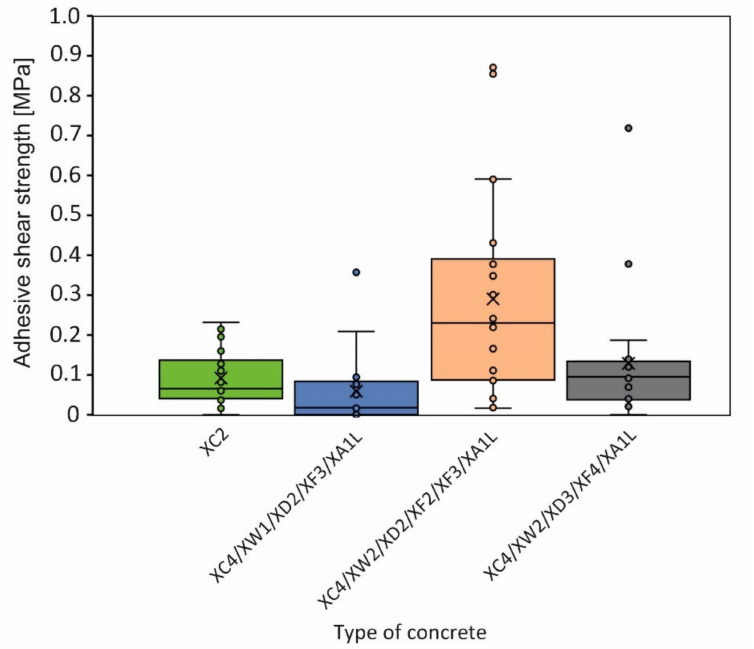
Figure 13. Boxplot of the adhesive shear strength between stone and concrete mortar for different concrete